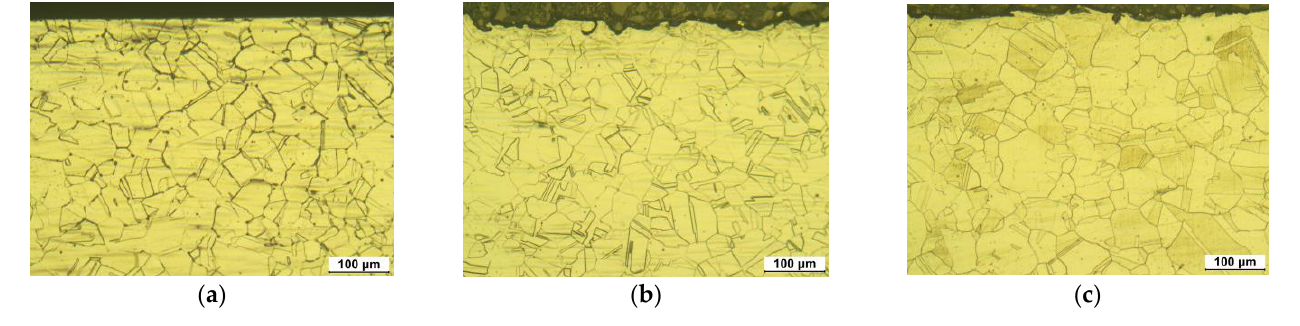
Figure 7. Optical microstructure of the cross-section of 304L base metal after LP (OM, ×200, 10% oxalic acid): ( a ) 304LB, ( b ) 304LB-L-NC, and ( c ) 304LB-L-WC.